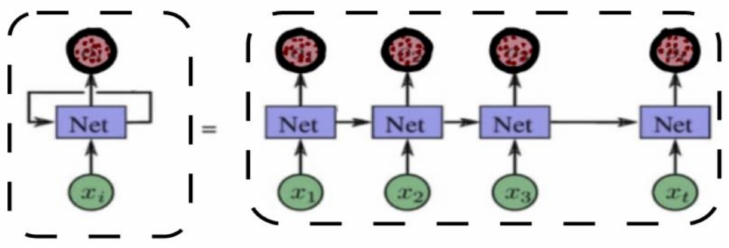
Figure 4. Recurrent neural network generic